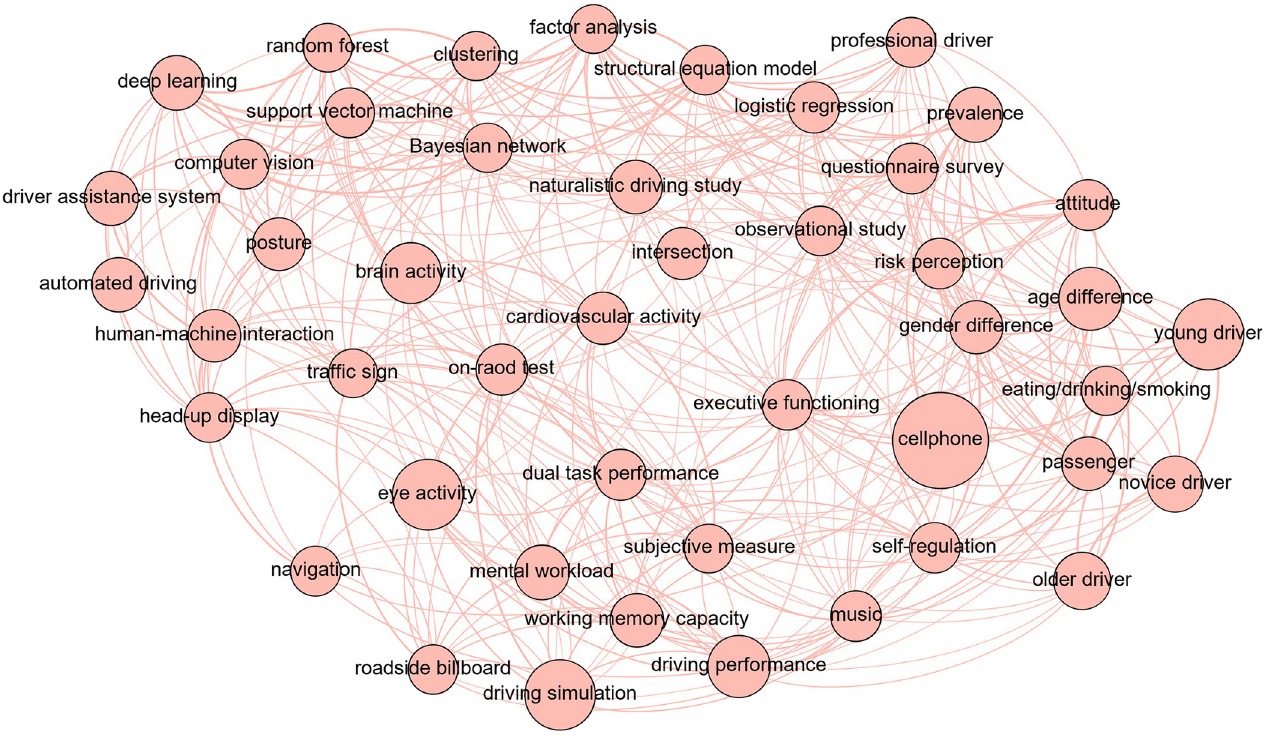
Fig 7. Visualization of all the keywords and